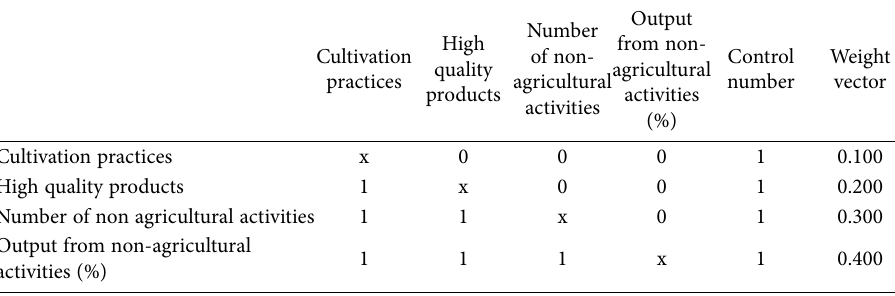
Table 5 . Weight matrix related to multifunctional